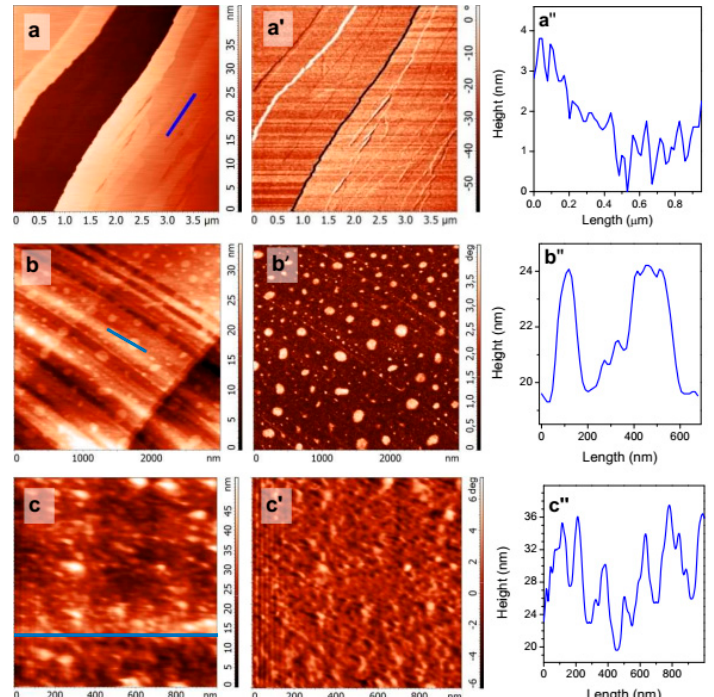
Figure 2. Tapping mode AFM images taken in ambient water from galena surfaces ( a , a’ ) fractured, ( b , b’ ) pre-treated using the temperature difference procedure in water (galena (PbS) heated in air to 50 °C and then contacted with water cooled to 5 °C); ( c , c’ ) heated at 50 °C and then reacted with cold (5 °C) 10 mM potassium n-butyl xanthate ( KBX); ( a – c )—height, ( a’ – c’ )—phase contrast, ( a’’ – c’’ )—relief profiles along the blue lines at the height images ( a ), ( b ) and ( c ), respectively.